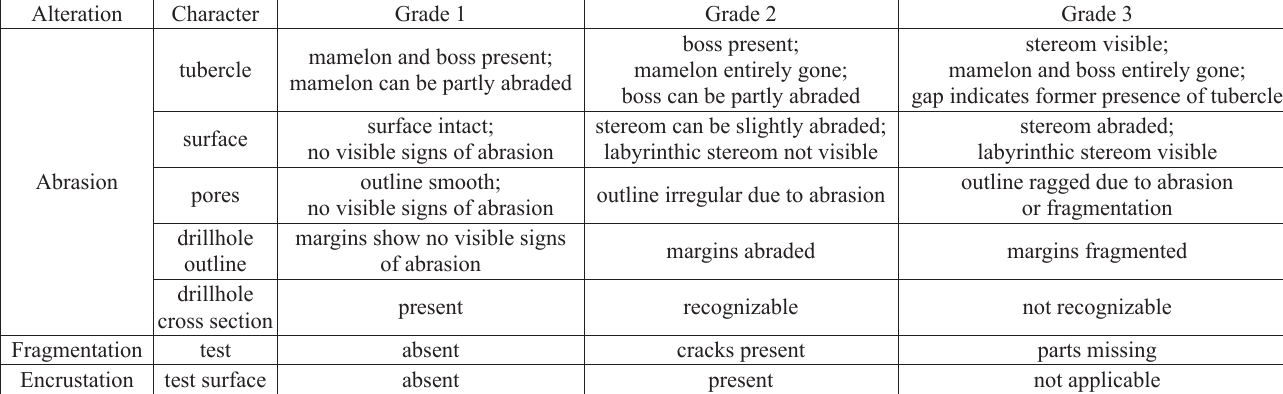
Table 2. Taphonomic description of test surface characters of Echinocyamus pusillus . Alteration